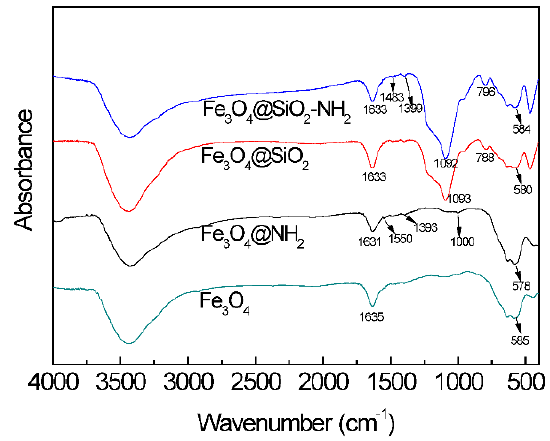
Figure 2. The Fourier ‐ Transform Infrared Spectroscopy (FT ‐ IR) for the magnetic nanoparticles (MNPs).